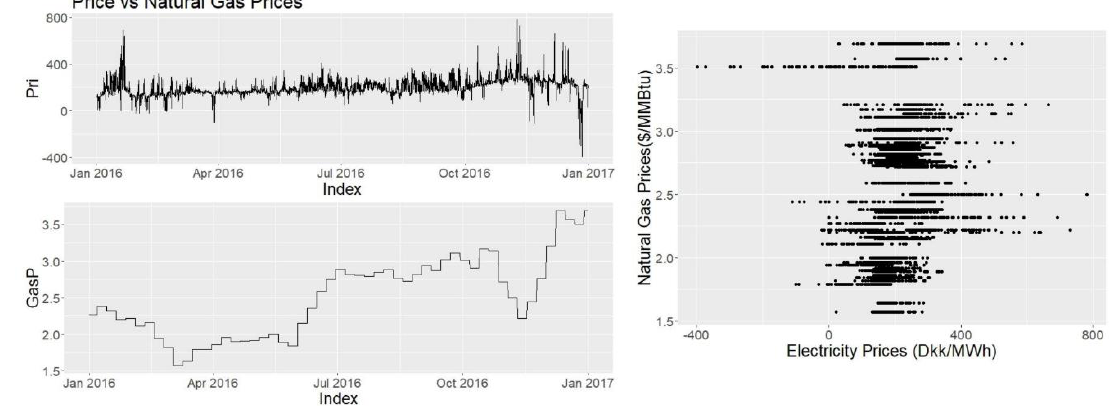
Figure 13. Price vs. Natural gas prices.